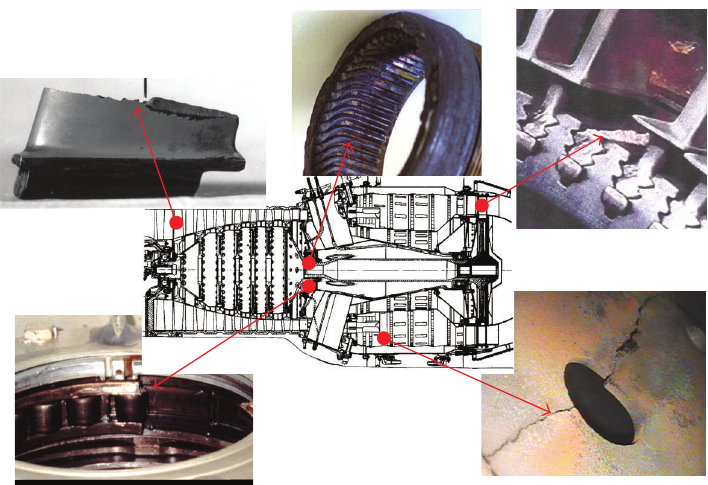
Figure 1: Problems of structural fatigue in turbine engines.